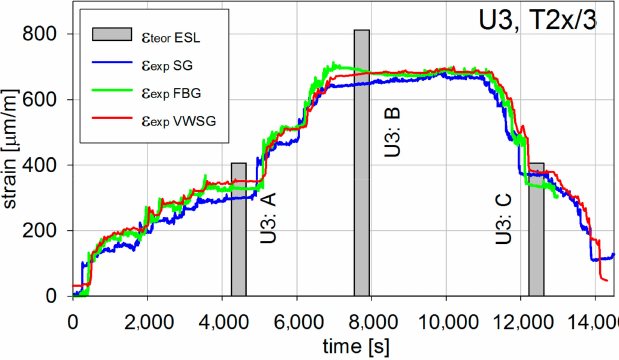
Figure 16. Longitudinal strains in T2x / 3 for the U3 test.